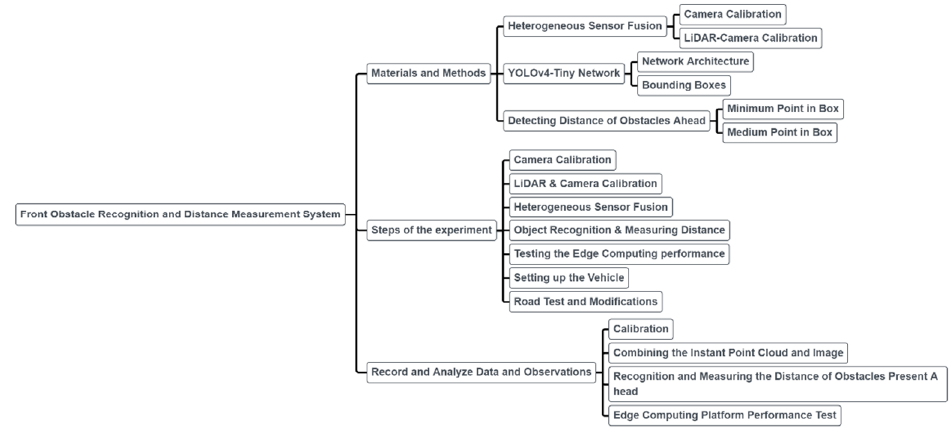
Figure 2. Mind Map.